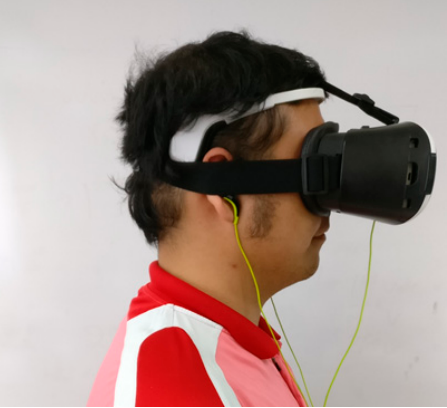
Figure 2. Headset devices (EEG and VR) worn by a participant where the positions of sensors are placed on the frontal scalp (AF7, AF8) and earlobes (TP9, TP10).